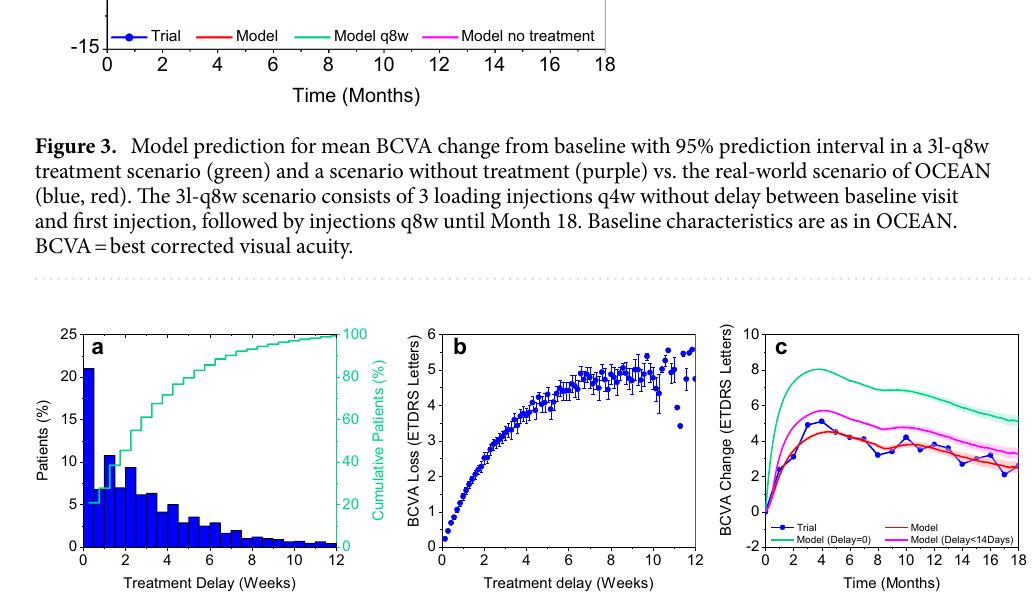
Figure 4. Consequences of delay between diagnosis and first injection on visual acuity. ( a ) Observed treatment delay in OCEAN. ( b ) BCVA loss due to treatment delay in Month 18 (mean ± 95% prediction interval). ( c ) Mean BCVA change from baseline with 95% prediction interval: model prediction for a scenario with no treatment delay (green) and delay limited to a maximum of 2 weeks (purple) but frequency of injections and baseline characteristics as in OCEAN vs. the real-world scenario of OCEAN (blue, red). BCVA = best corrected visual